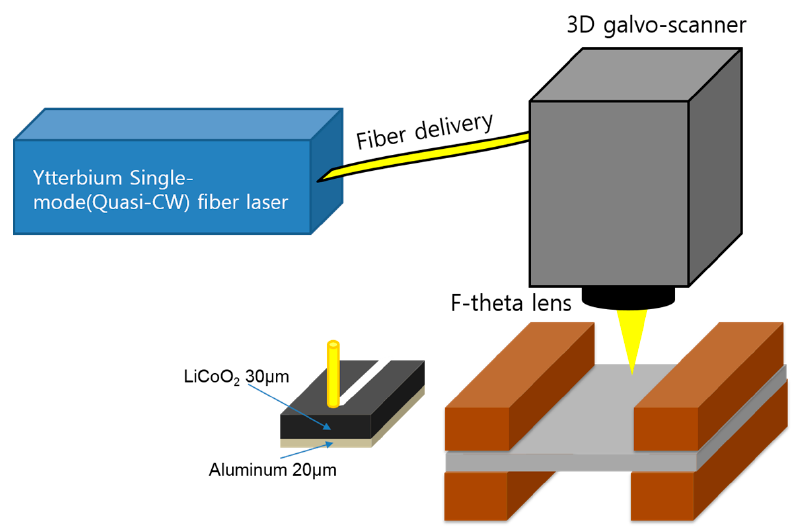
Figure 1. Cathode sample and Experimental set-up.